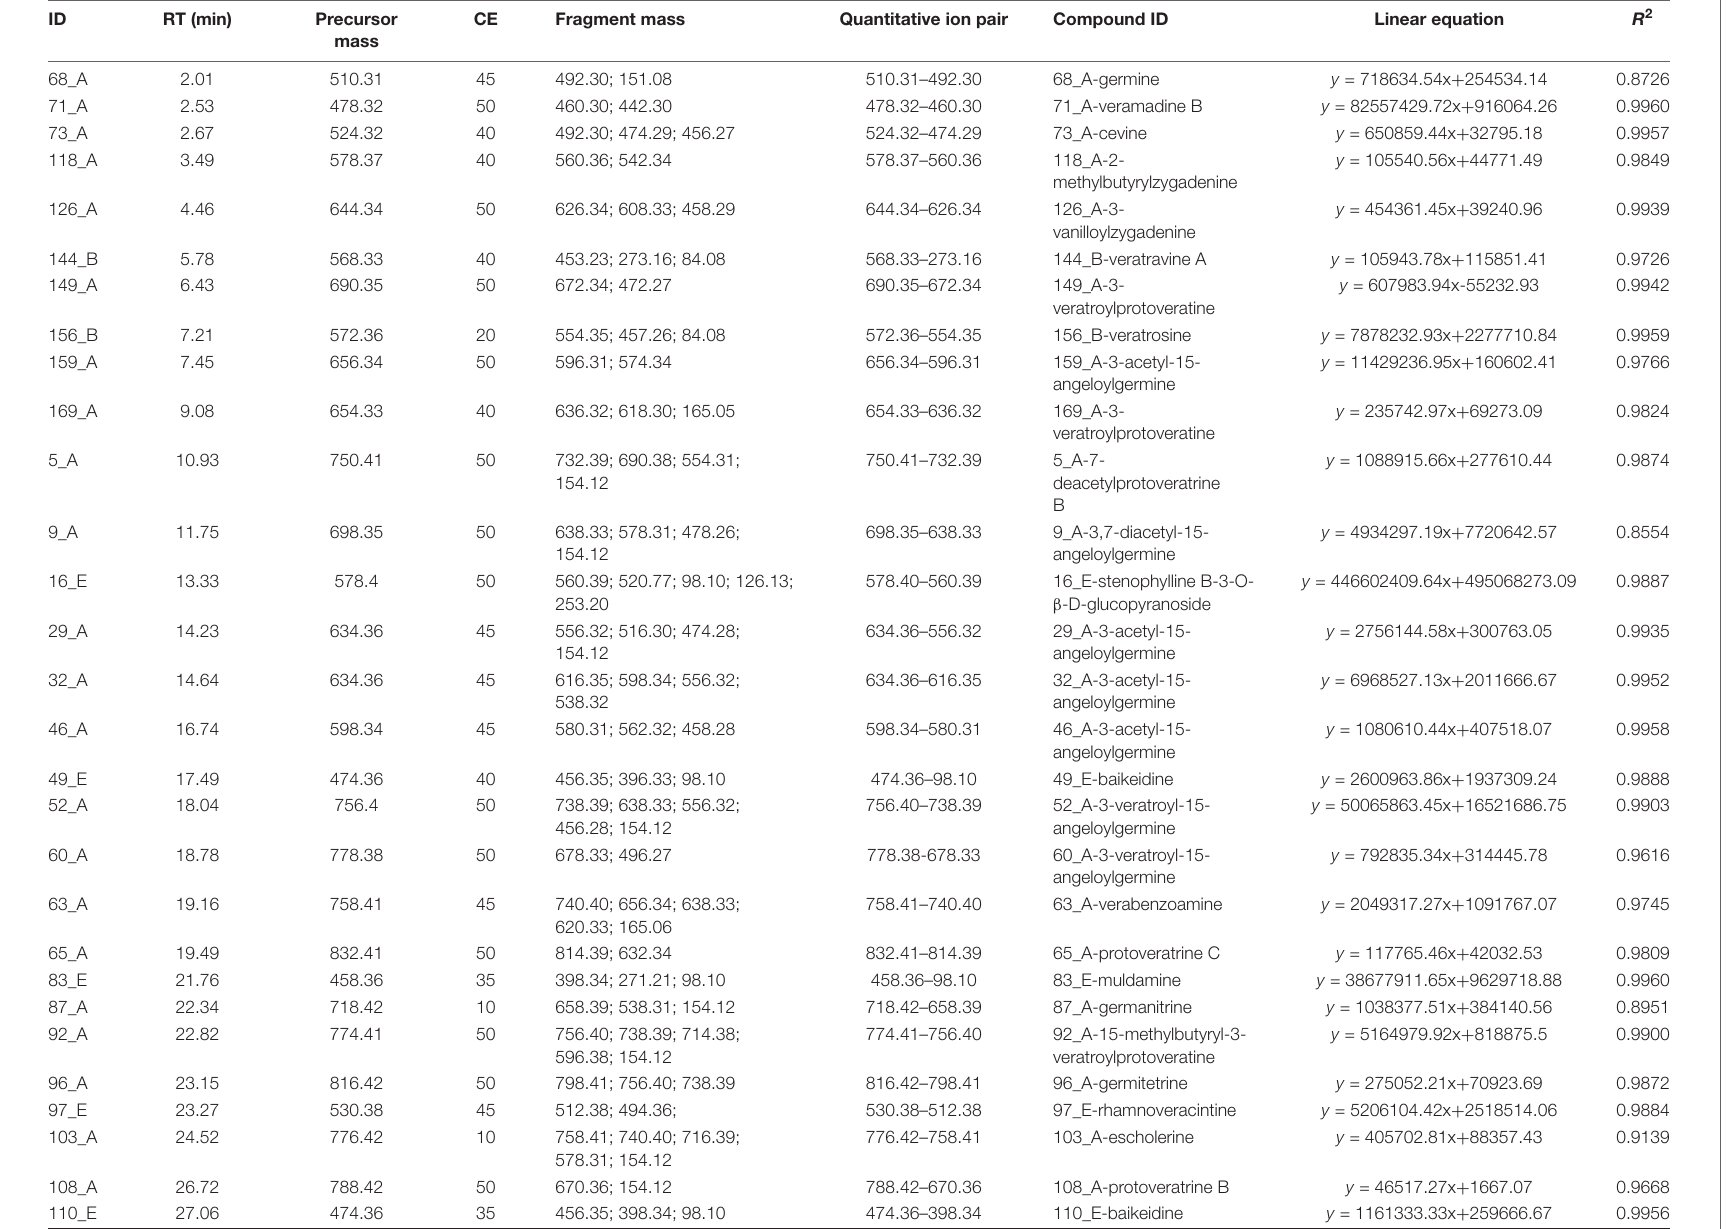
TABLE 3 | Selected ion pairs used in MRM